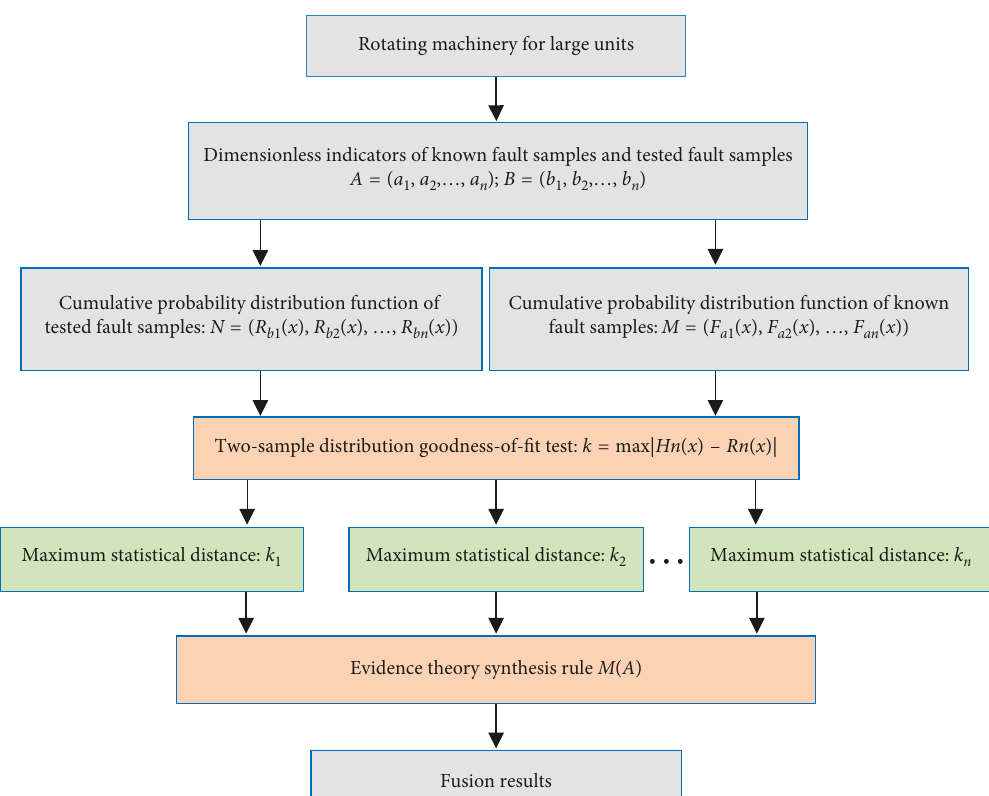
Figure 1: Diagram of composite fault diagnosis for rotating machinery of a large unit based on evidence theory and multi-information